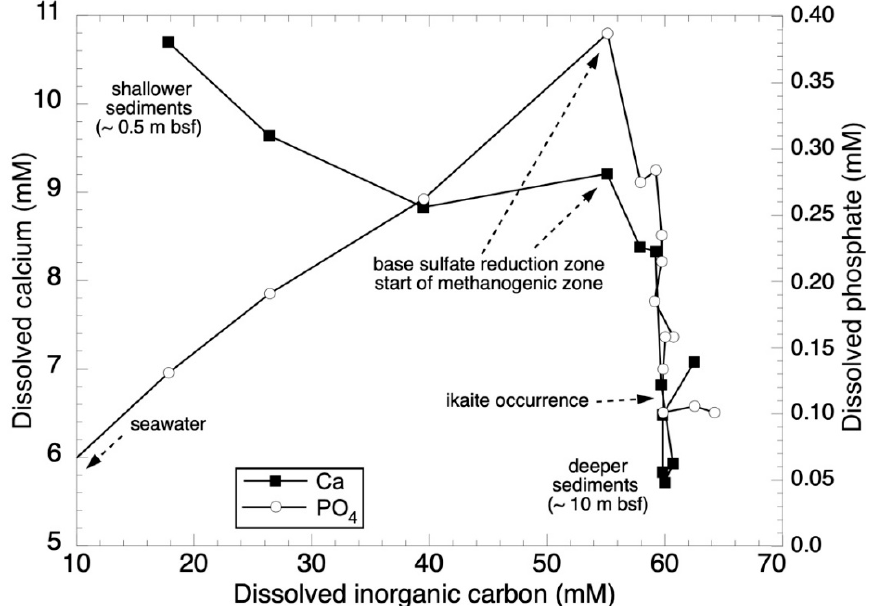
Figure 5. Stoichiometry between dissolved calcium and phosphate with dissolved inorganic carbon (DIC) in core ANT 1138-2. DIC:P has a linear relationship within the diagenetic sulfate-reduction zone (SRZ), but dramatically departs, as indicated at depths beneath the base of the SRZ. Calcium shows little change in the SRZ, then also decreases and tracks phosphate at depths below the SRZ. The sediment depth of ikaite occurrence is shown.